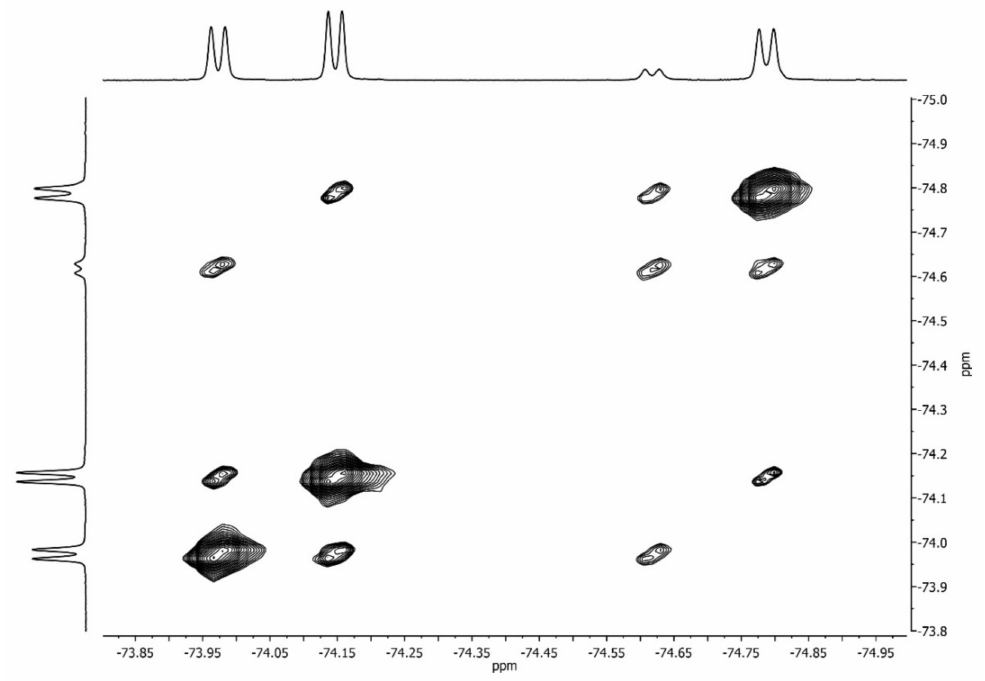
Figure 10. 19 F EXSY spectrum of racemic 1 in CDCl 3 at 23 ◦ C.